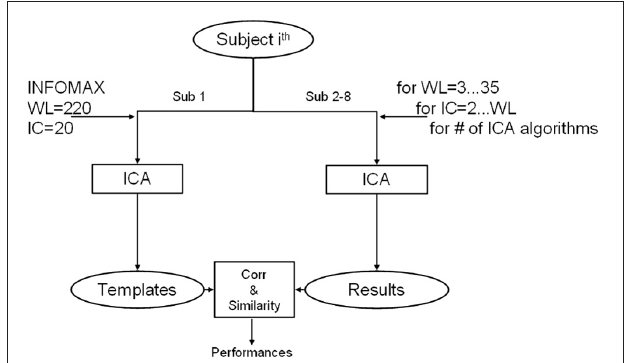
FIGURE 3 | Diagram of adopted method for ICA algorithm comparison. For one separated subject data are exploited for creating templates using INFOMAX with model order (ICs) of 20 and window length (WL) equal to the entire available time course. The ICA algorithms are then tested iteratively on all the other subjects for each combination of IC and WL. Results of each computation are compared with templates and evaluated in terms of spatial similarity and temporal